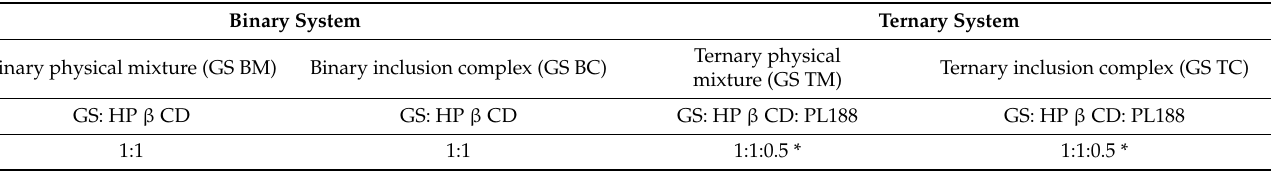
Table 1. Formulation composition of inclusion complex of